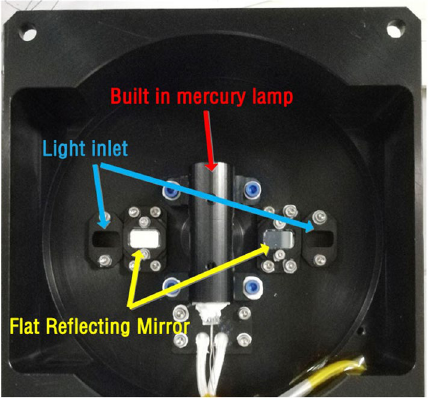
Figure 7. Mercury lamp in solar irradiance